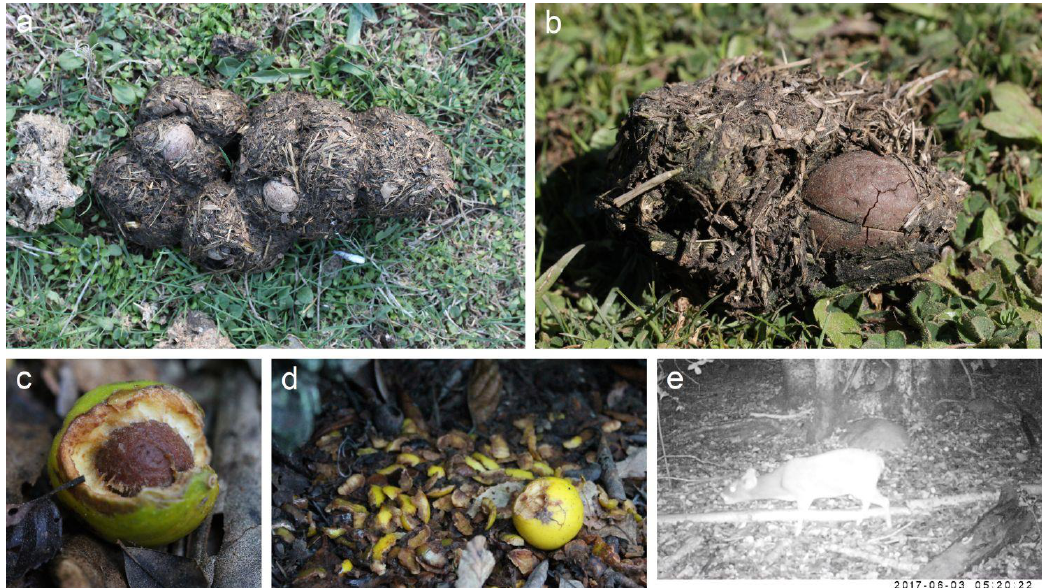
Figure 2. Evidence of consumption of Gomortega keule fruit by animals. ( a ) Two intact stones are visible in pig feces; ( b ) A stone showing an incipient crack in pig feces; ( c ) A fruit gnawed by rodents; ( d ) Gnawed fruit and flesh leftovers; ( e ) A cervid ( Pudu puda ) consuming the fruit flesh (image courtesy: Carlos Reyes and Alexis Villa—CONAF Maule).